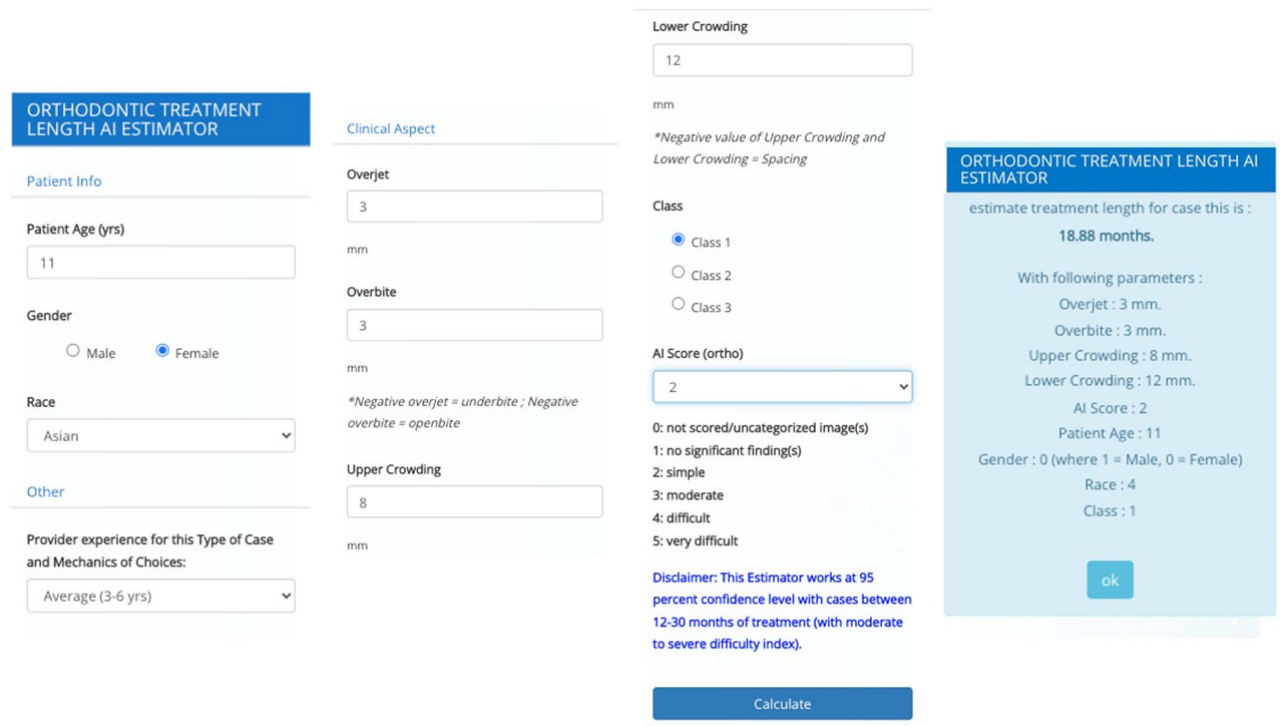
Figure 10. Graphical user interface for mobile application for treatment length prediction.